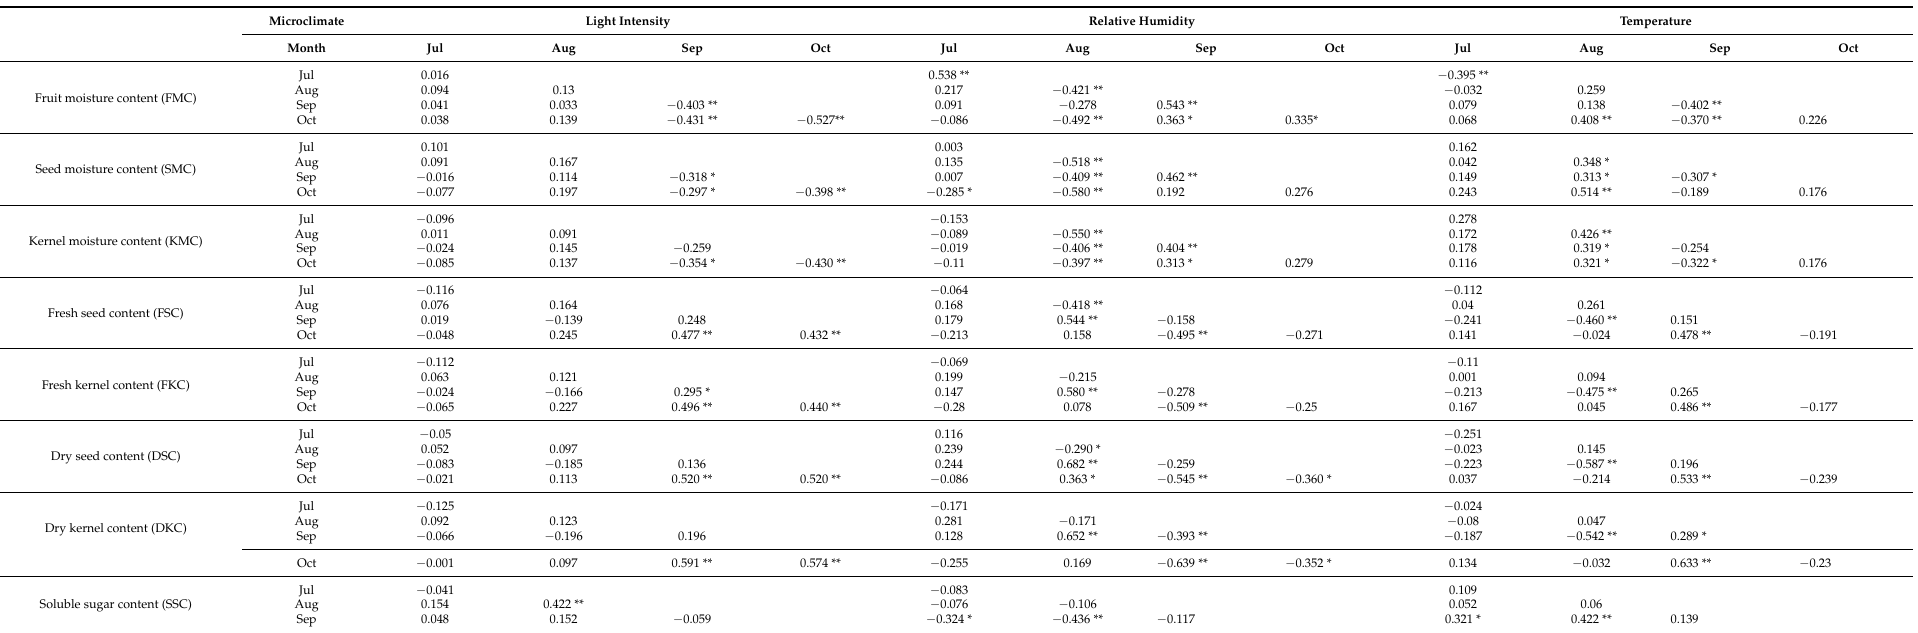
Table 3. The correlations between microclimatic factors and fruit qualities during the period